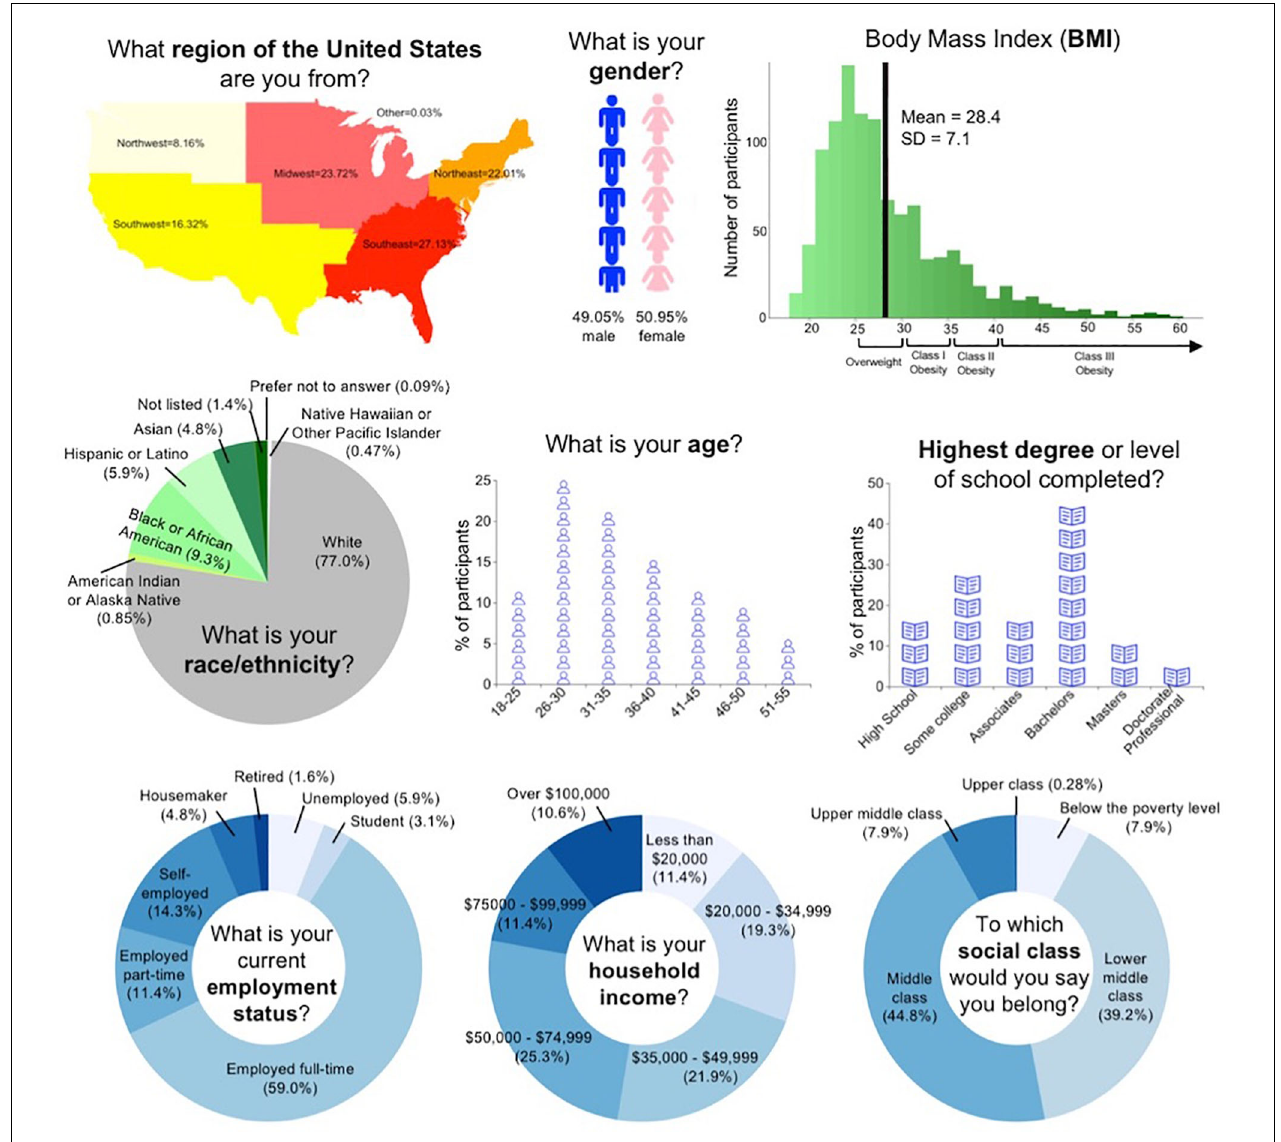
FIGURE 2 | Participant demographic